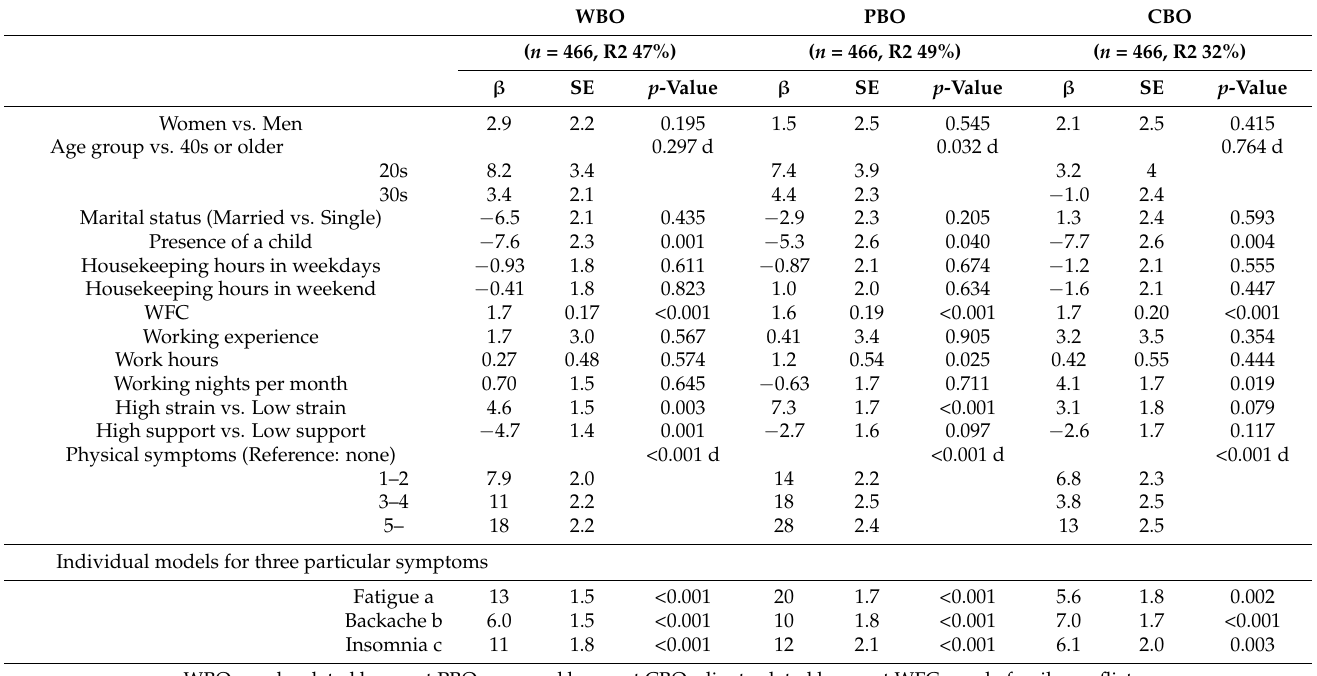
Table 6. Multivariable general linear models of an effect of covariates according to burnout subscale among hospital workers.